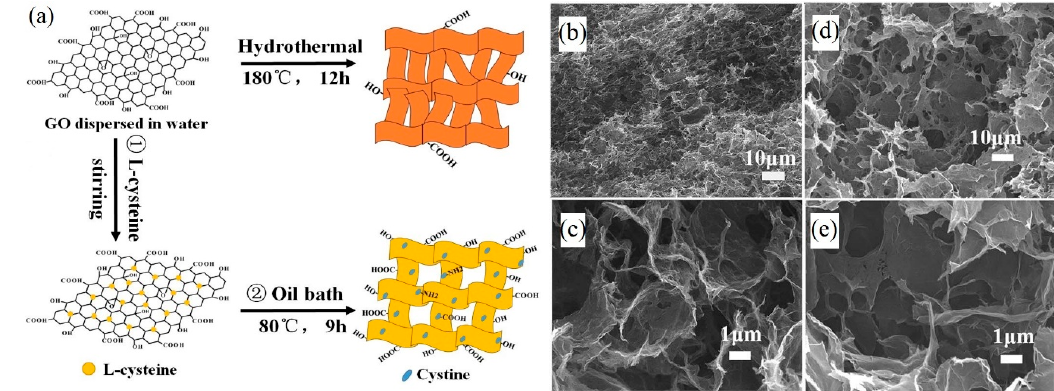
Figure 1. ( a ) Schematic illustration of the chemical reduction and hydrothermal methods. Scanning electron microscopy (SEM) images of graphene aerogel (GA) without L -cysteine ( b , c ). SEM images of GA with L -cysteine ( d , e ). Adapted from [4], with permission from © 2015 The Royal Society of Chemistry .